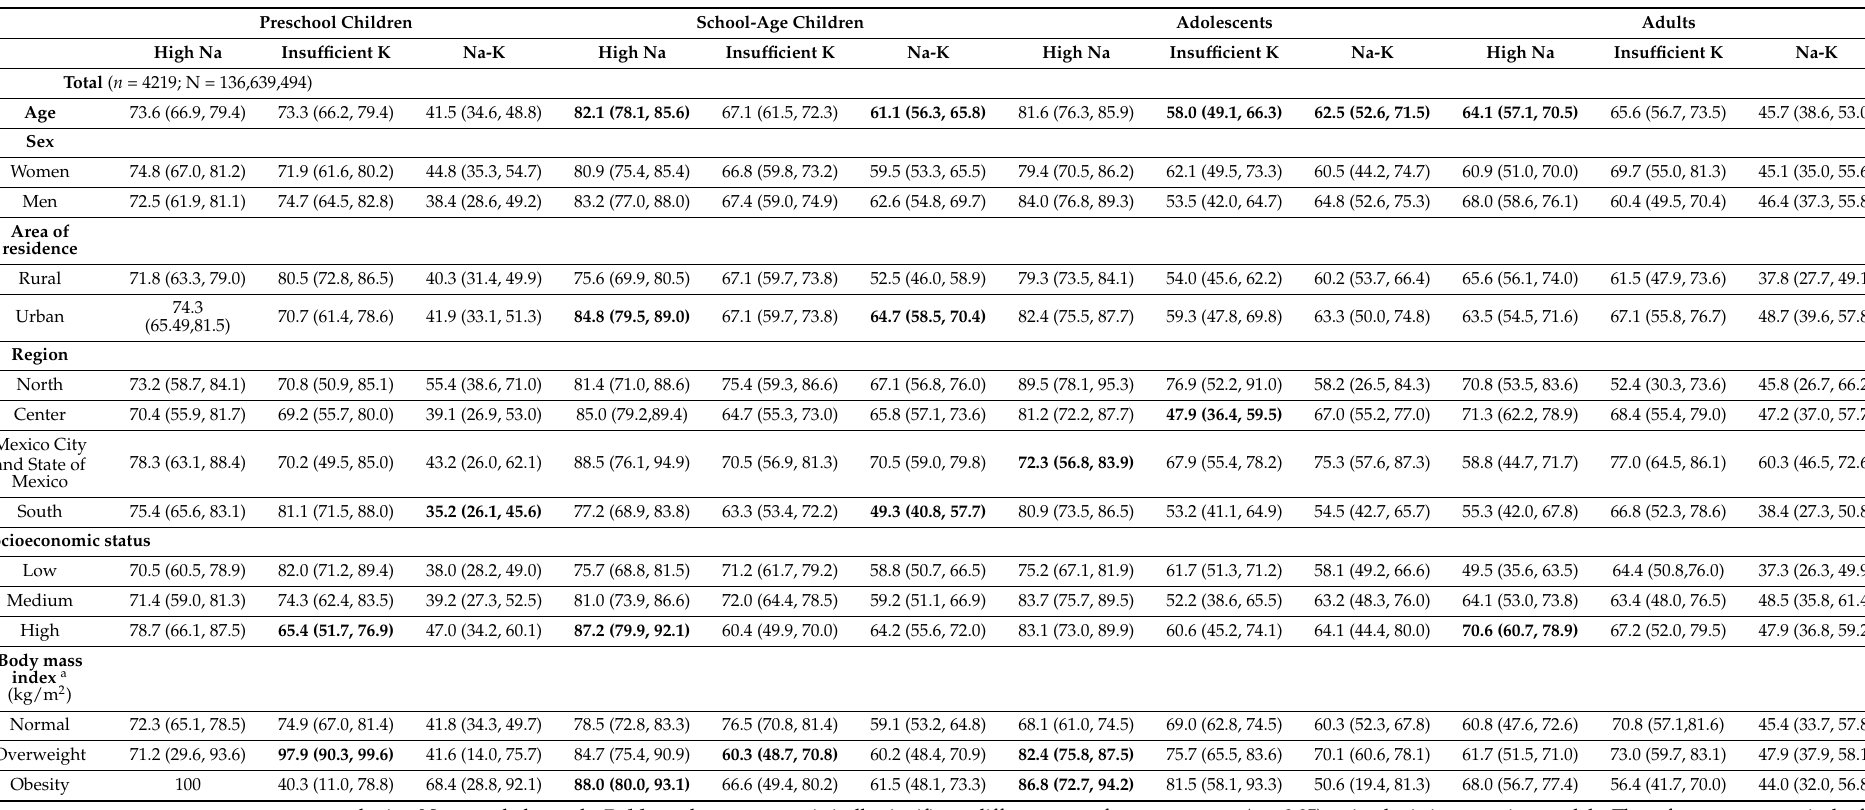
Table 3. Proportions of high sodium, insufficient potassium intake, and sodium–potassium ratio by age group in Mexican population. ENSANUT-2016 1,2,3